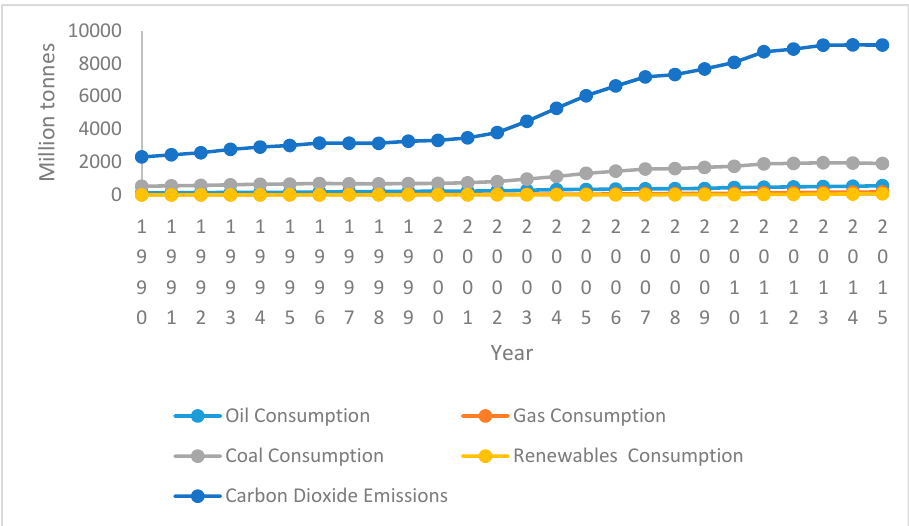
Figure 1. Energy consumption and carbon dioxide emissions from 1980 to 2015 in China.